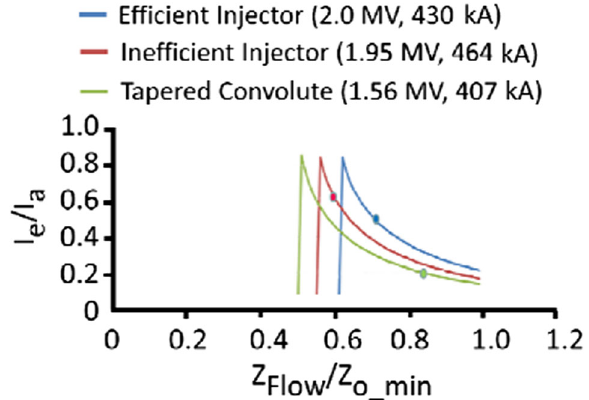
FIG. 13. The fraction of current flowing in electrons is shown =Z as a function of Z for the two MITE injector experi- Flow o min ments and the tapered convolute discussed in Sec. II B. The operating points are shown by the circles on the respective curves. ¼ 7 . 6 Ω All have Z o min